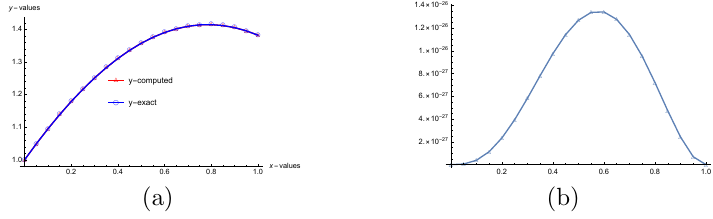
Figure 1. (a) and (b) show the solution curve and absolute errors for Example 5 taking h = 1 / 20 using